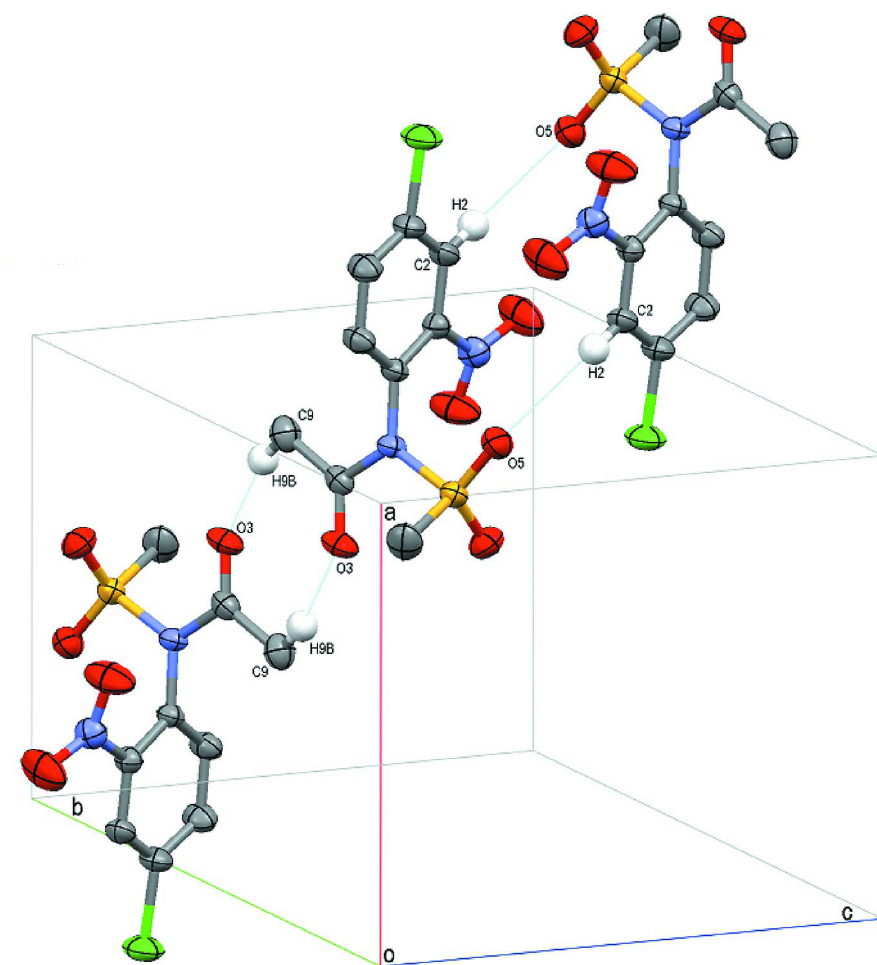
Perspective view of a portion of the crystal packing, viewed approximately down the b-axis, showing hydrogen bond interactions (dashed lines) along the [101] direction. H atoms not involved in hydrogen bonding have been omitted for